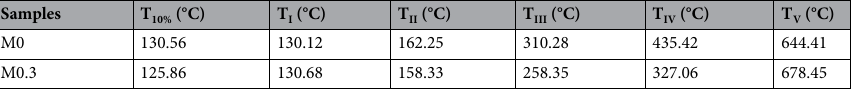
Table 3. TGA results of M0 and M0.3 hydrogel. T 10% the temperature of the original mass loss reaches to 10%. T I , T II , T III , T IV , T V the temperature of the first, second, third, fourth, fifth peaks